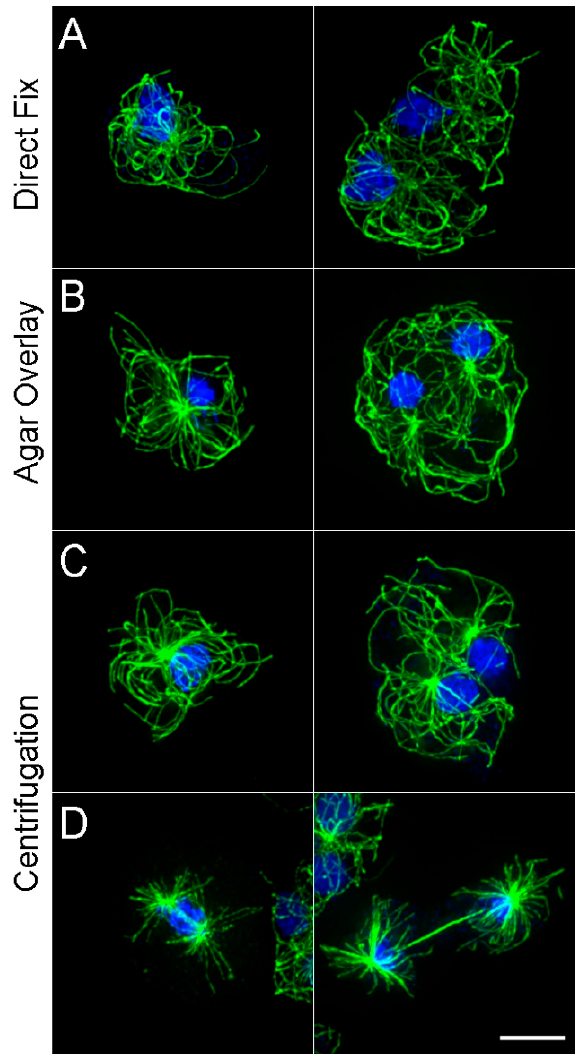
Figure 2. Examples of antibody-labeled microtube (MT) patterns in cells ( A ) directly added to coverslips and fixed after a 10 min period; ( B ) cells fixed after overlay with agar sheets; and ( C , D ) cells fixed after 5 min centrifugation onto coverslips. Panels ( A – C ) show interphase arrangements of mononucleated cells (left) and binucleates (right). Panel ( D ) shows mitotic cells in late anaphase (left) and late telophase (right). While the three different cell preparations look similar, it is important to note that there are typically far fewer flattened cells on the direct fix coverslips and substantially fewer cells in general on the agarose overlay coverslip. MTs are shown in green, DNA in blue, Scale bar = 5 μ m.